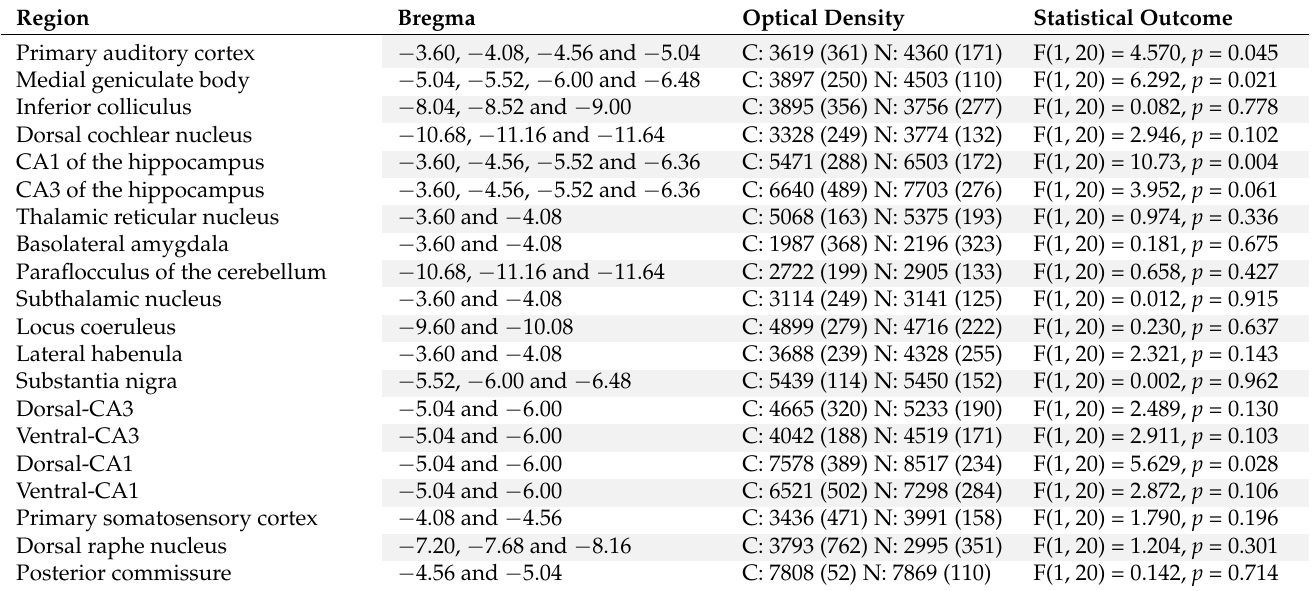
Table 1. Cytochrome c Oxidase optical density results of the measured regions in noise-exposed group (N) vs. control (C)